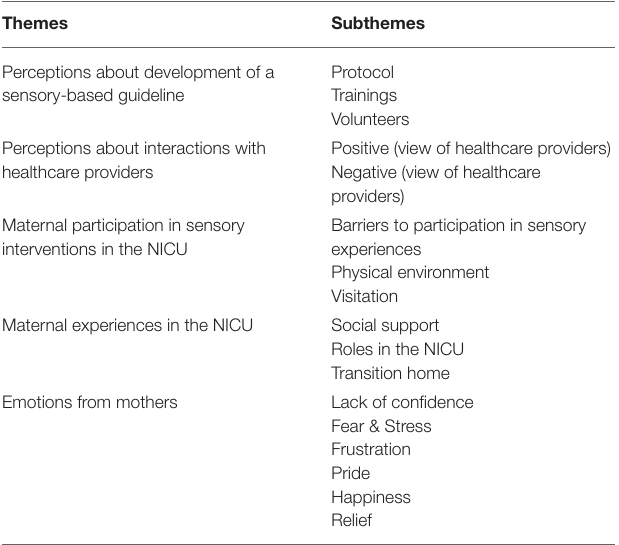
TABLE 2 | Themes and subthemes of this study ( n = 20).